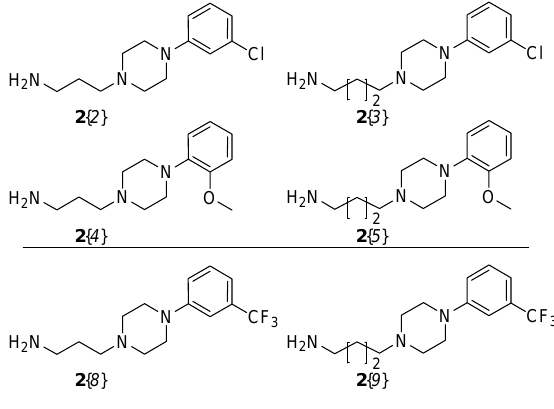
Figure 4. Diversity reagent 2 . Amines 2 { 8-9 } [14] used in the current project.